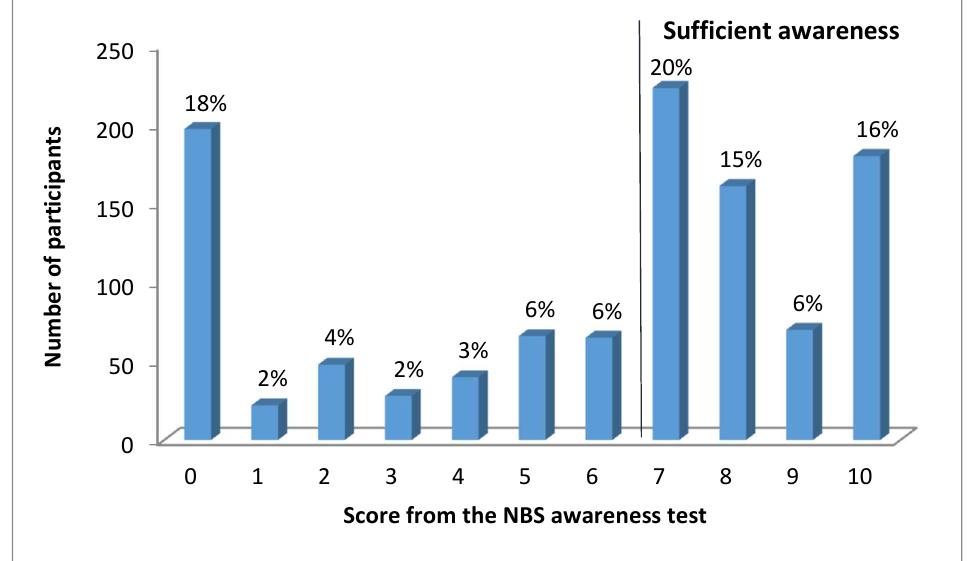
Figure 2. The distribution of scores from the questionnaire evaluating awareness about NBS.